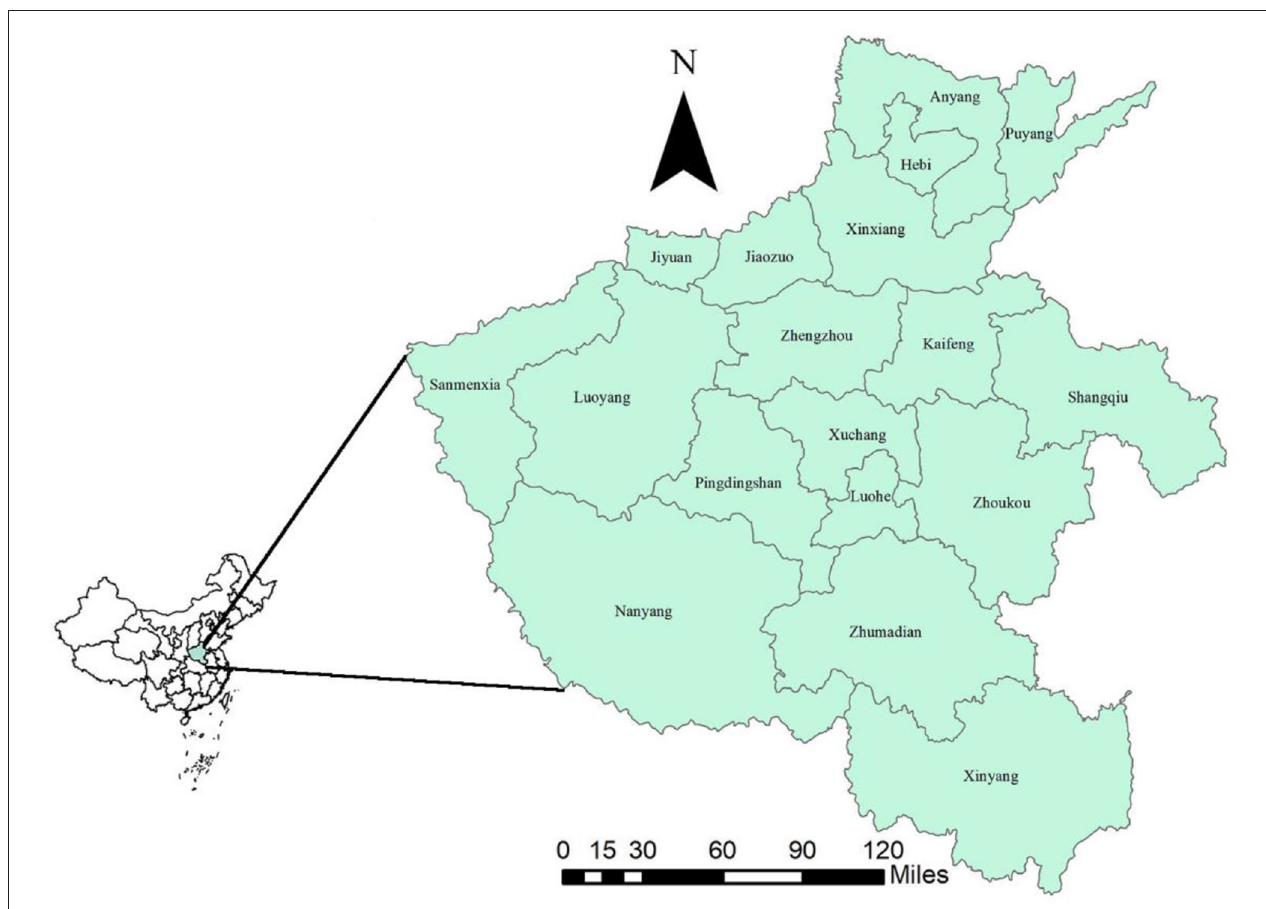
FIGURE 1 | Location of Henan Province (the map was created with ArcGIS software, 10.5).